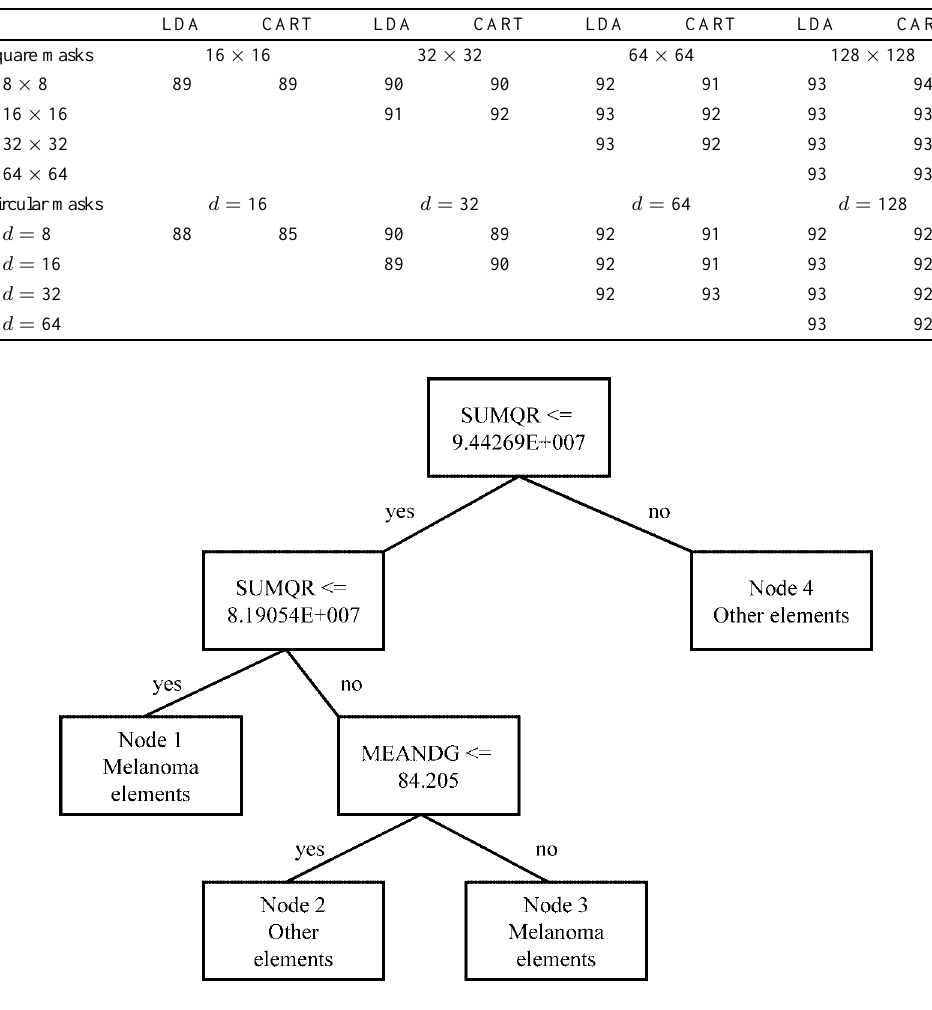
Fig. 2. Classification tree separating melanoma elements from other tissue